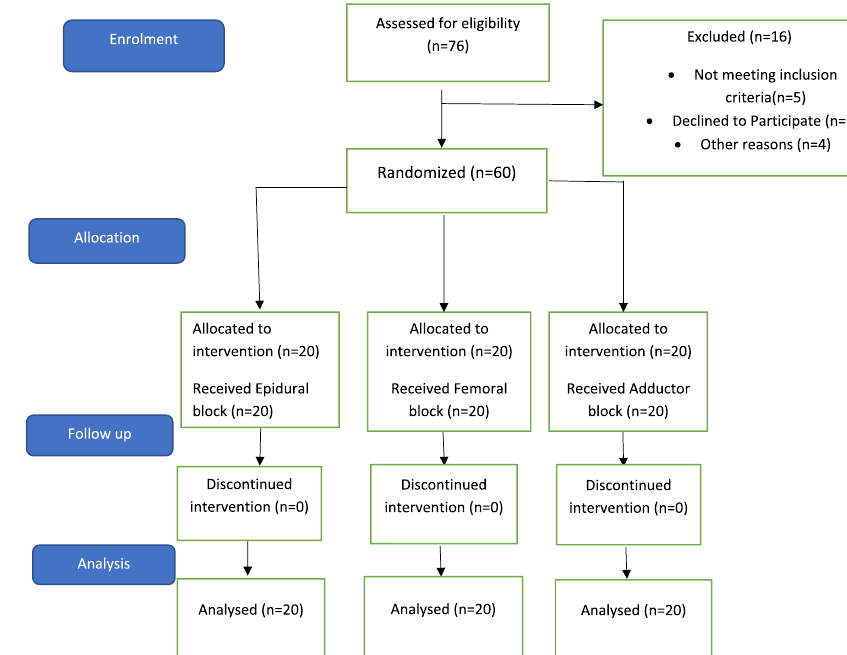
Fig. 3 Showing the total number of enrolled patients and allocated